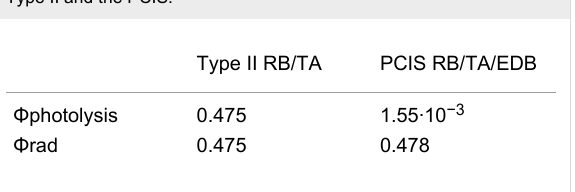
It is worth emphasizing the important points and advantages of